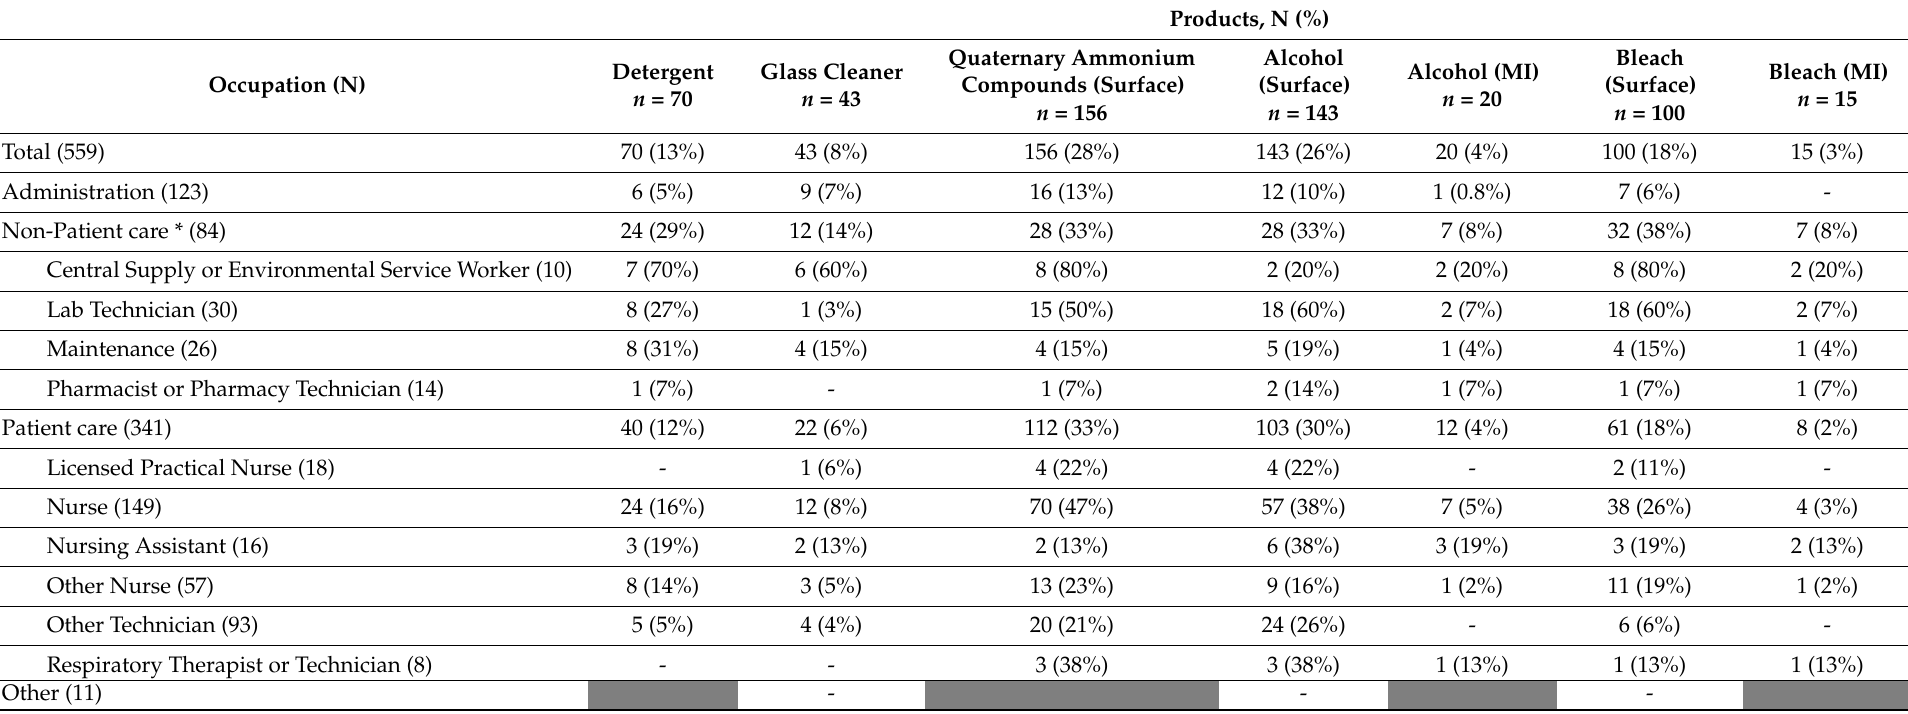
Table 3. Distribution of occupation by cleaning products used, N